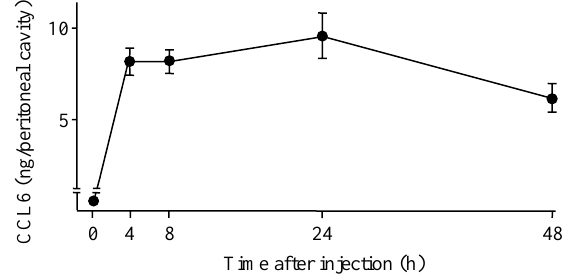
FIG. 1. Production kinetics of CCL6 in the peritoneal fluids after thioglycollate injection. At indicated intervals after thioglycollate injection, mice were euthanized and the peritoneal fluids were harvested (each point, 10 (cid:1) / 14 mice). CCL6 levels in the peritoneal fluids were measured by ELISA.